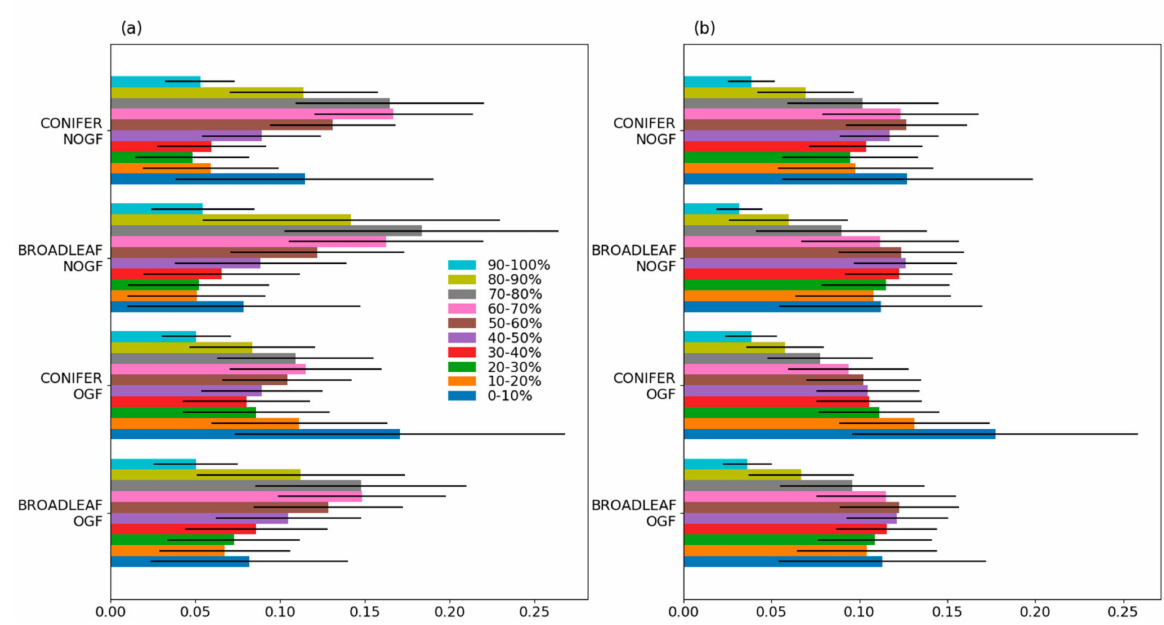
Figure 8. Mean vegetation thickness of old-growth forest (OGF) and non-OGF (NOGF) canopy with height above ground for ( a ) maximum canopy height of greater than 25 m, and ( b ) maximum canopy height less than 25 m, with the canopy divided into ten height strata (0–10% being the closest to the ground and 90–100% being closest to canopy top). Error bars show standard